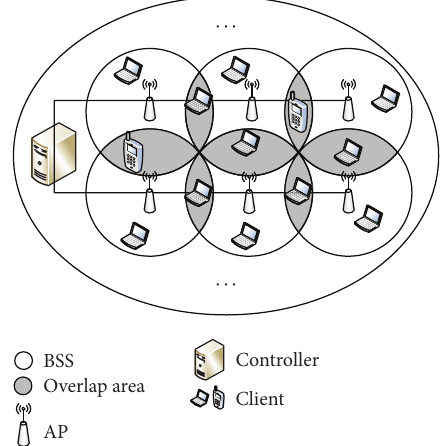
Figure 1: Work scene under the coexistence of high-density AP.